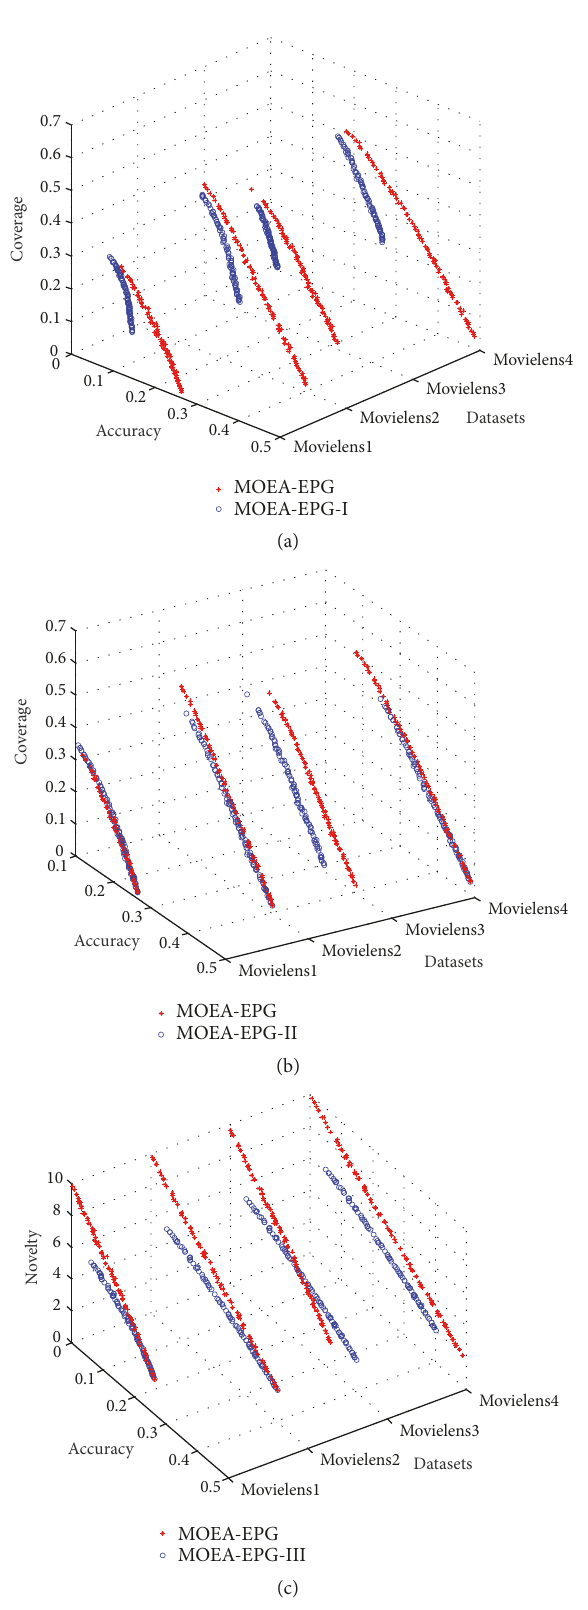
Figure 11: Final solutions of MOEA-EPG and comparison algorithms under the accuracy-coverage space for (a) MOEA-EPG-I and (b) MOEA-EPG-II, and those under the accuracy-novelty space for (c)